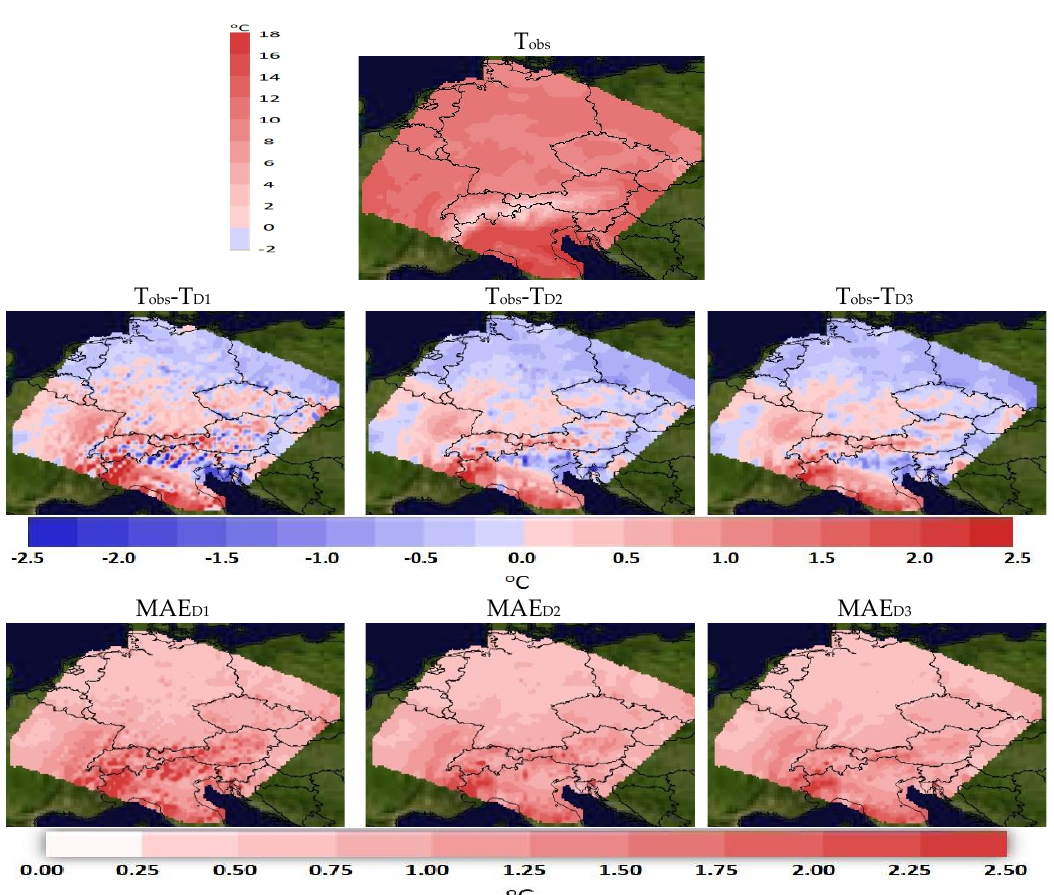
Figure 2. Spatial distribution plots for annual mean temperature: observed data (upper panel), differences between observed and simulated data for the three nested domains (middle row), and the related mean absolute error (MAE) (lower row).